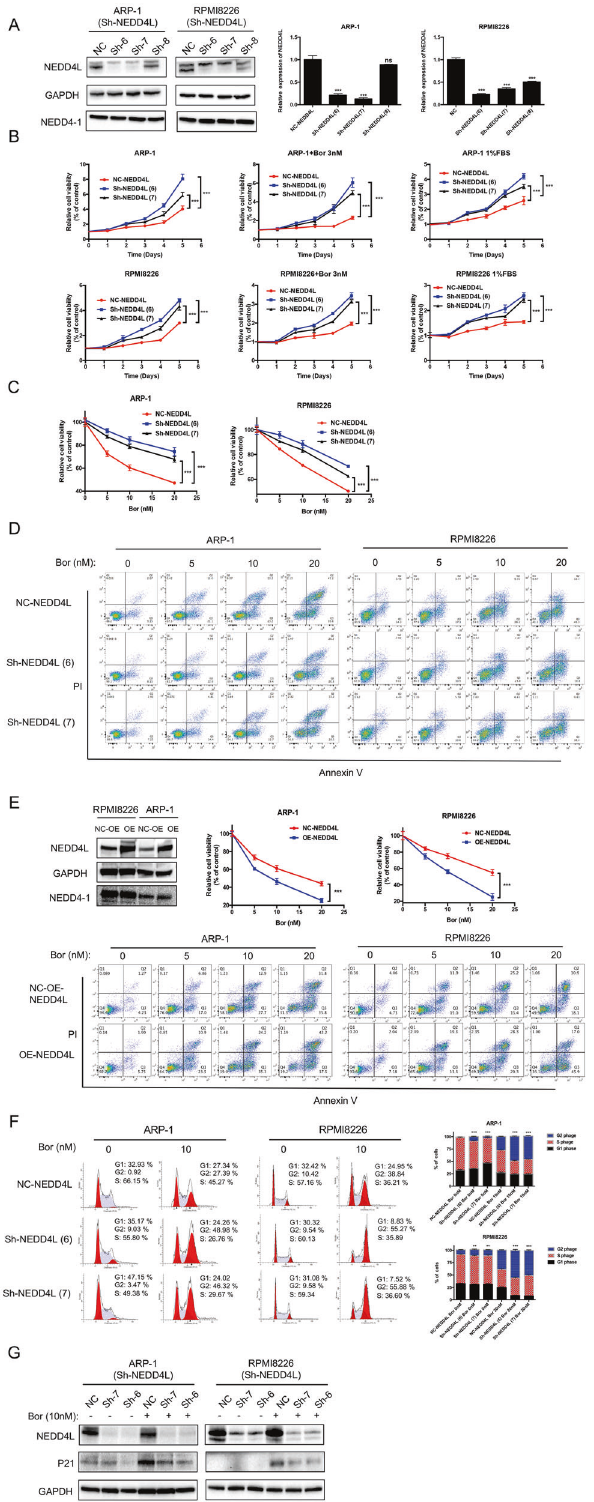
Fig. 3 NEDD4L regulates the Bor sensitivity in MM cells. A Western blotting and qPCR analyses showing the expression of NEDD4L in NEDD4L-KD and control cells. “ ns ” means “ nonsigni fi cant ” . B CCK-8 cell proliferation assay in cell lines with stable NEDD4L KD with or without exposure to 3 nM Bor or 1% FBS for fi ve days. C , D Cell apoptosis was detected by CCK-8 and fl ow cytometry in cell lines with stable NEDD4L KD treated with the indicated concentration of Bor for 24 h. E Western blotTING analysis showing the expression of NEDD4L in NEDD4L-overexpressing and control cells. Cell apoptosis was detected by CCK-8 and fl ow cytometry in cell lines with stable NEDD4L overexpression treated with the indicated concentration of Bor for 24 h. F Cell cycle assay performed by fl ow cytometry showing the percentages of cells in G1, S, and G2 phase in NEDD4L- KD cells treated with or without Bor for 24 h. The histograms show the percentages of HMCLs in G 1 , S, and G 2 phase in three independent experiments. G Western blot assay of NEDD4L and P21 in cells with stable NEDD4L KD after treatment with 10 nM Bor for 24